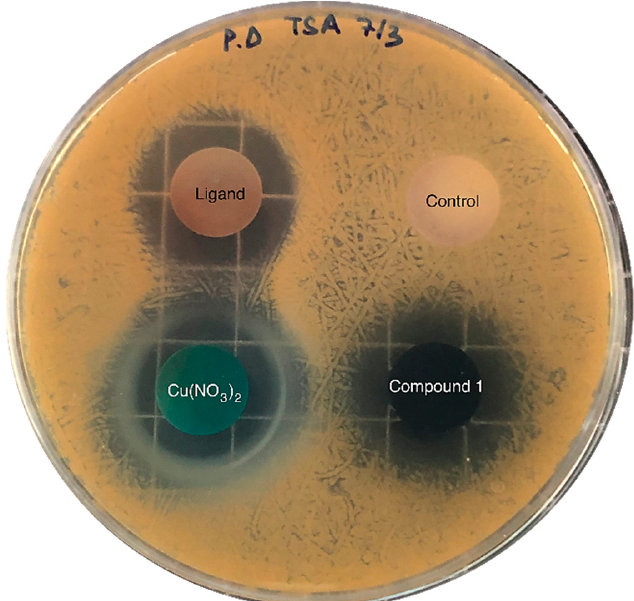
Figure 5. Diffusion assays showing the inhibitory activity against S. aureus of copper nitrate, H 3 L (ligand) and compound 1 . The negative control sample—without inhibitory activity—contained calcium phosphate, which was also used as a supporting material in the rest of the samples (25 mg of active compound and 75 mg of calcium phosphate). Table 1. Area of inhibition (cm 2 ) of the compound against S. aureus . Values are shown as mean ± standard deviation (SD, n = 3). The mass of Cu and H 3 L in each sample is also provided. Compound Inhibition Area (cm 2